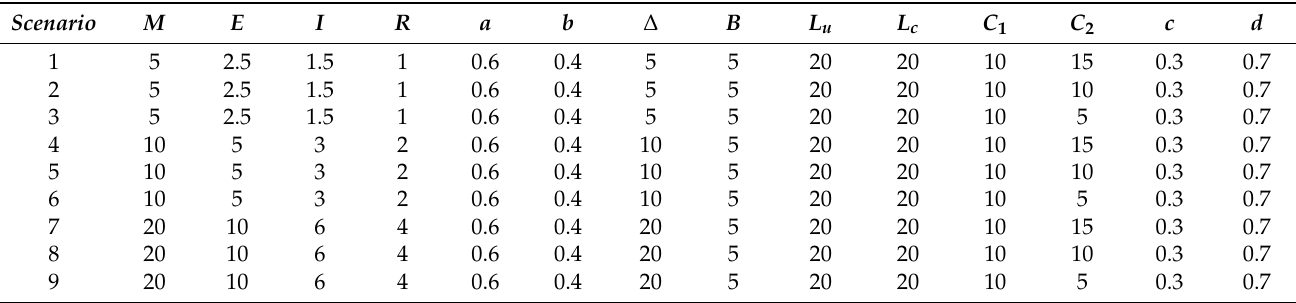
Table 5. Initial values of parameters in different